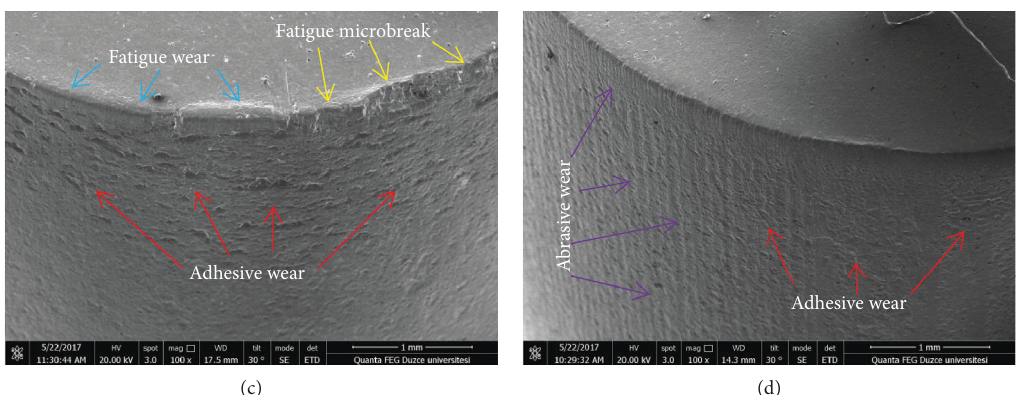
Figure 11: Edge and face wear of the circular zone of slot punch at the 26.500 strokes (slot punch 10.5 × 8.5 × 100mm in size). (a) HT (OM × 50). (b) CT (OM × 50). (c) HT (SEM × 100). (d) CT (SEM × 100).